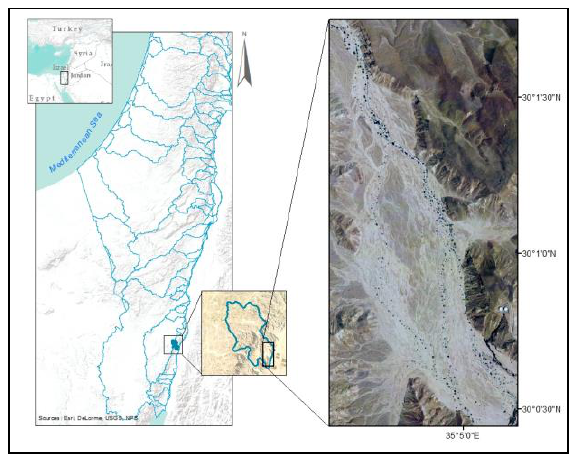
Figure 1. Study area. Left: The drain basin of Ktora wadi in southern Israel marked in dark blue. Right: The aerial Figure 2. Grouping analysis of the acacia trees to three spatial photograph of the study area. Flow direction is from north-west related groups based on NDVI value and tree size. to south-east.